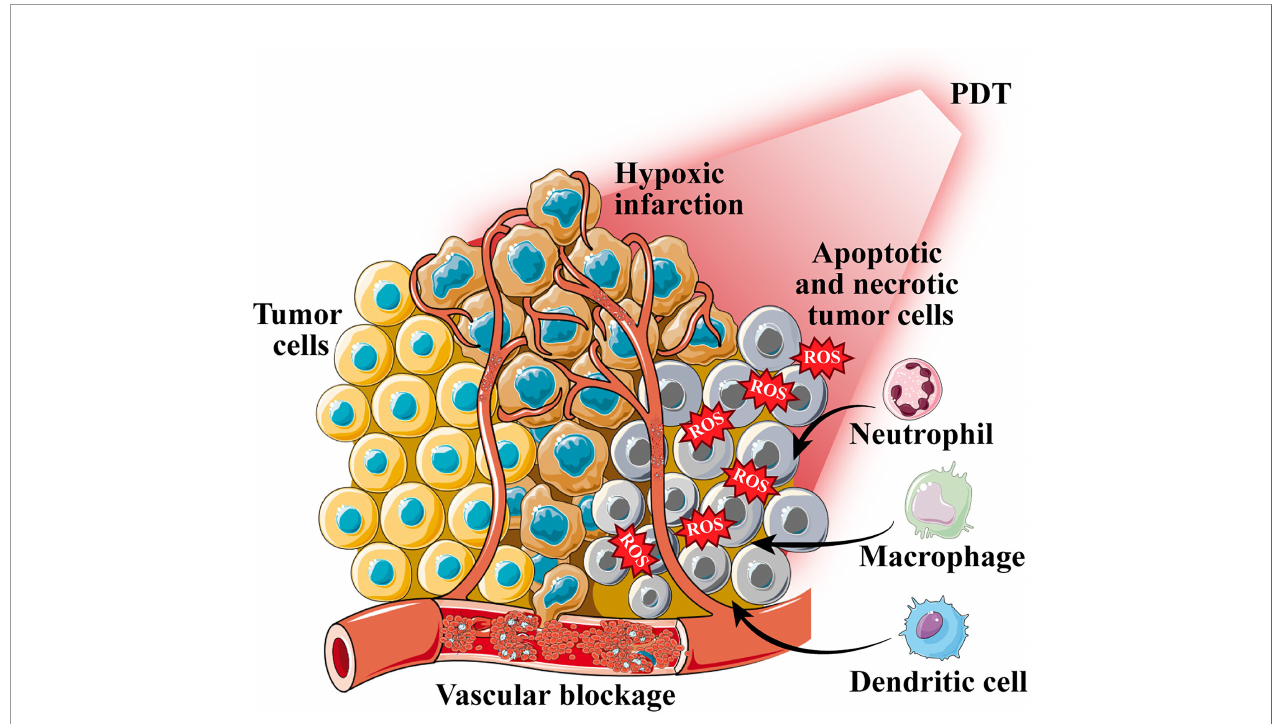
FIGURE 2 | The tumor damage mechanism caused by photodynamic therapy (PDT). PDT generates reactive oxygen species (ROS) to induce cell apoptosis and necrosis; photosensitizers target the vascular system to form thrombi, causing hypoxic infarction of tumor tissues; apoptotic and necrotic tumor cells recruit a variety of white blood